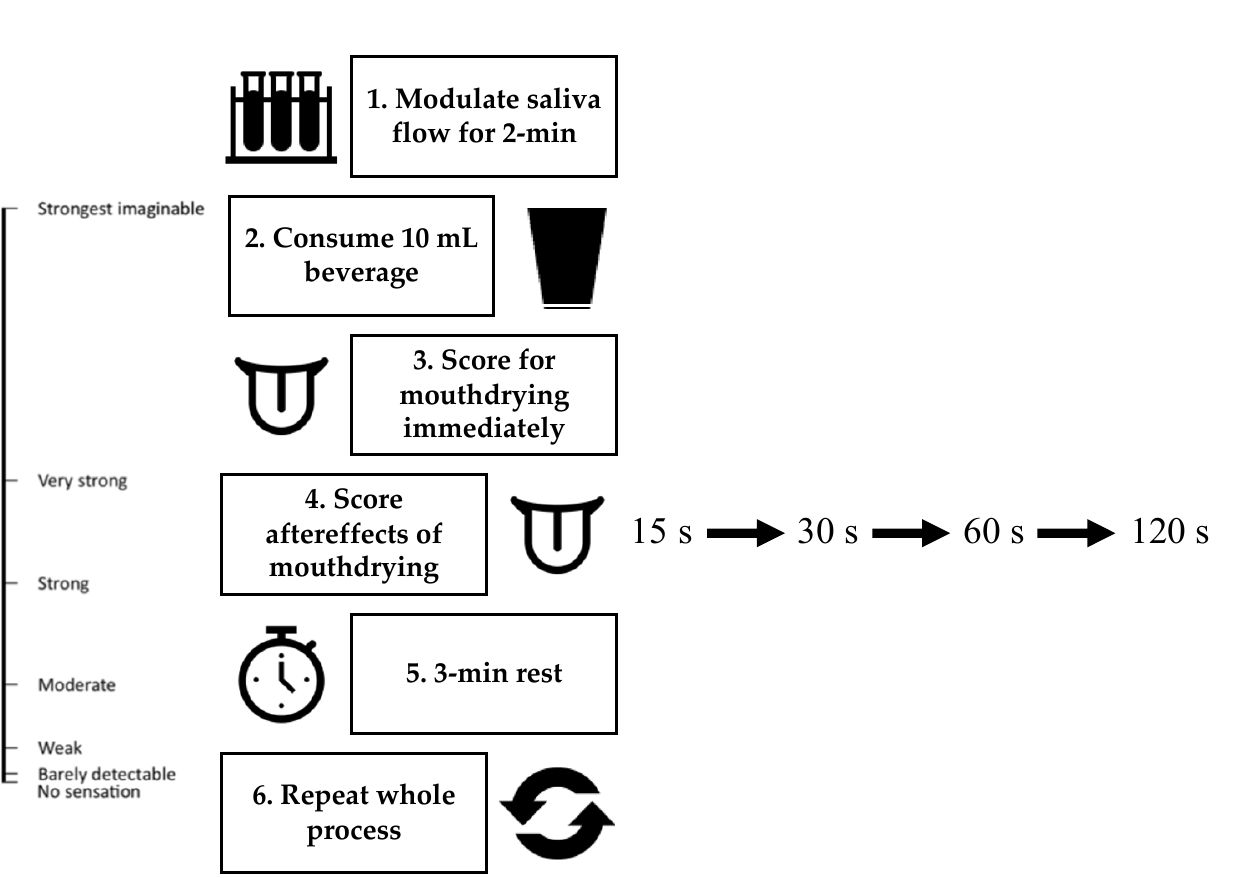
Figure 2. Brief overview of modulating saliva flow and mouthdrying perception protocol.